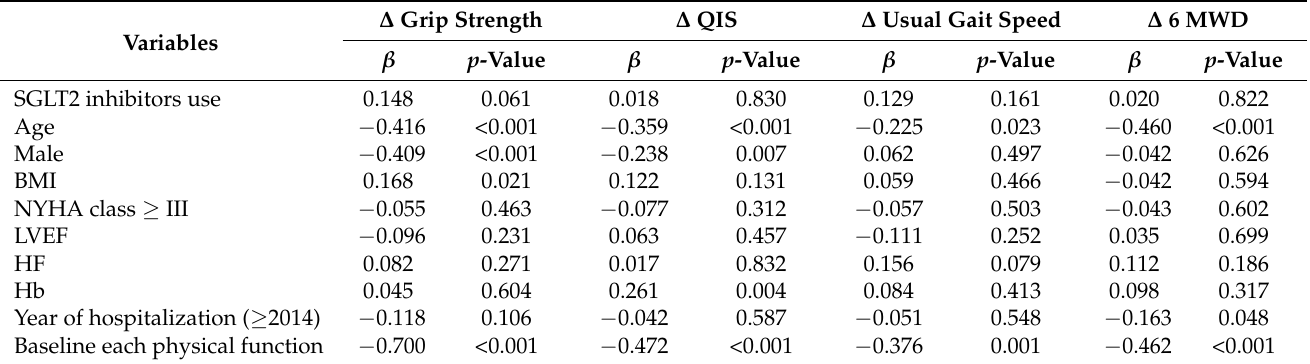
Figure 2. Comparison of ∆ physical functions with and without SGLT2 inhibitor use in a mixed- effects model. There was no significant time × group interaction ( p = 0.178) for change in Grip strength. There was no significant time × group interaction ( p = 0.575) for change in QIS. There was no significant time × group interaction ( p = 0.757) for change in Usual gait speed. There was no significant time × group interaction ( p = 0.151) for change in 6 MWD. QIS, maximal quadriceps iso- Table 2. Association of physical functions with SGLT2 inhibitors use.